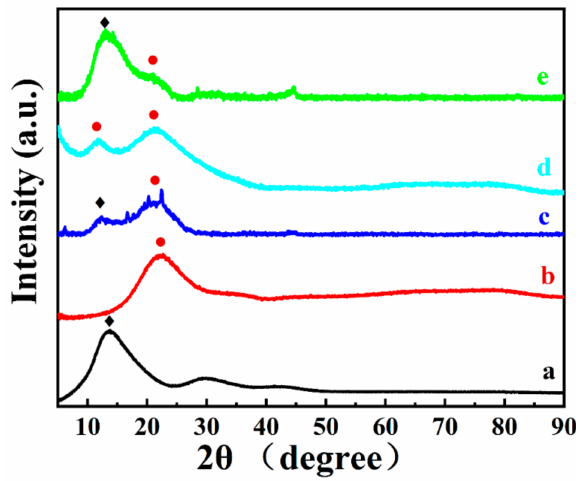
Figure 5. X-ray diffraction patterns of ( a ) PMMA, ( b ) micron size silica, ( c ) PMMA-micron size silica, ( d ) nanosilica and ( e ) PMMA-nanosilica ( • —silica, (cid:7)